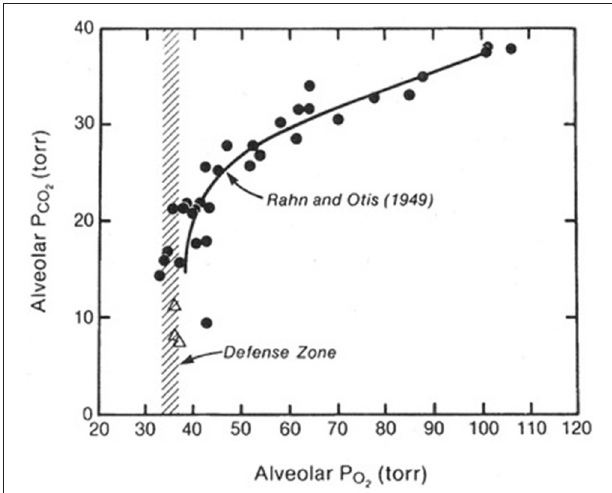
FIGURE 1 | Values of the PO 2 and P CO2 in the alveolar gas of climbers as they ascend from sea level (top right) to the Everest summit (bottom left). The PO 2 falls because of the reduction in barometric pressure. The P CO2 falls because of the increasing alveolar ventilation. Above an altitude corresponding to a P CO2 of about 20mm Hg (about 7000m), there is no further fall in the PO 2 . In other words, this is defended at about 35 mmHg. This can only be done if the P CO2 is continually reduced further by extreme hyperventilation as the altitude rises. Modified from Rahn and Otis (1949) and West et al.